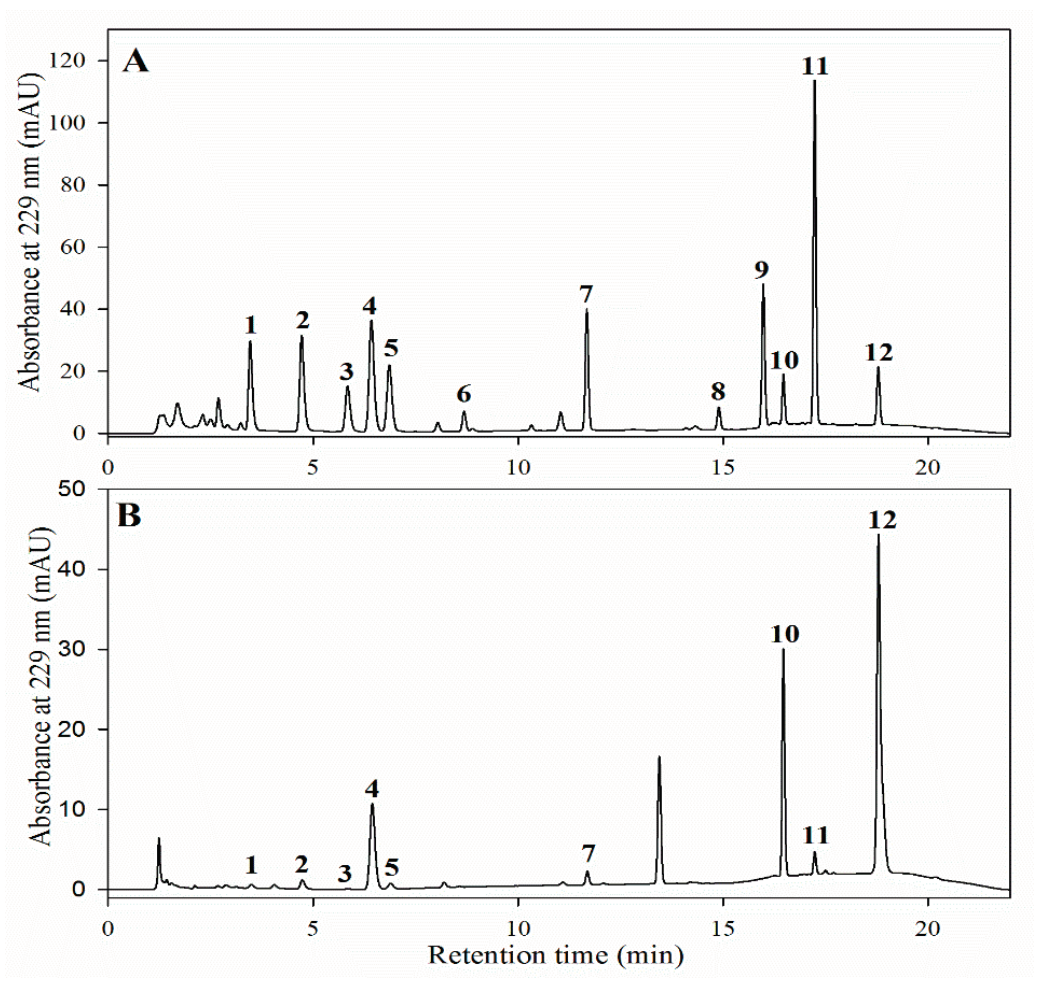
Figure 1. Ultra performance liquid chromatography (UPLC) chromatograms of desulfo-GSLs standards ( A ) and kale sample extract ( B ). Peak identification 1: glucoiberin; 2: progoitrin; 3: epiprogoitrin; 4: glucoraphanin; 5: sinigrin; 6: glucoraphenin; 7: gluconapin; 8: glucobarbarin; 9: glucobrassicanapin; 10: glucoerucin; 11: glucobrassicin; and 12: